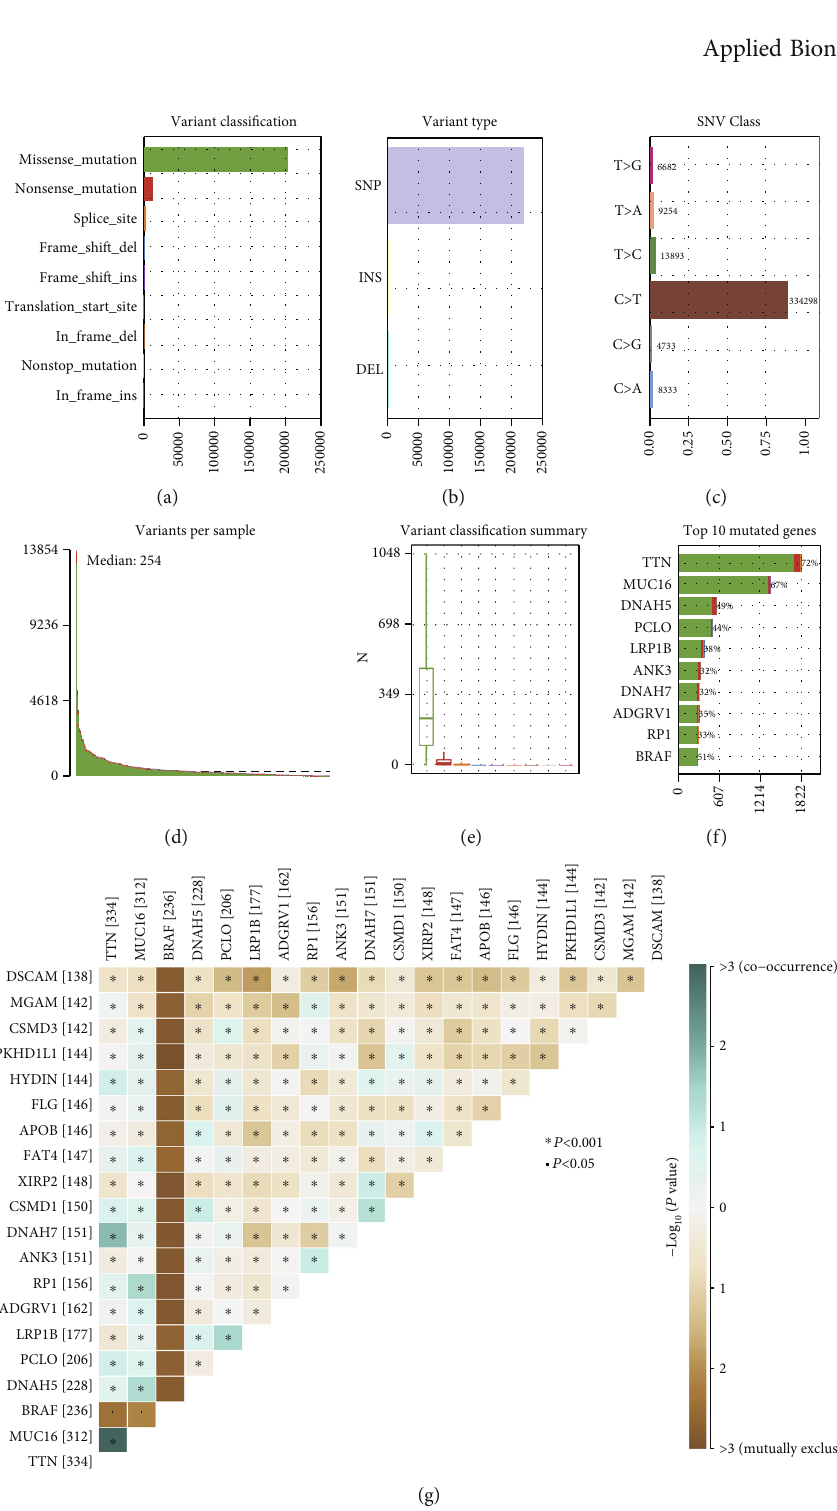
Figure 2: Summary of the mutation information with statistical calculations. (a – c) According to the classi fi cation of di ff erent types of mutations, missense mutations account for the largest proportion, SNP happened more frequently than insertion or deletion, and C > T was the most common of SNV. (d, e) The burden of tumor mutations in particular samples; (f) the top 10 mutated genes in SKCM; (g) the coincident and exclusive associations across mutated